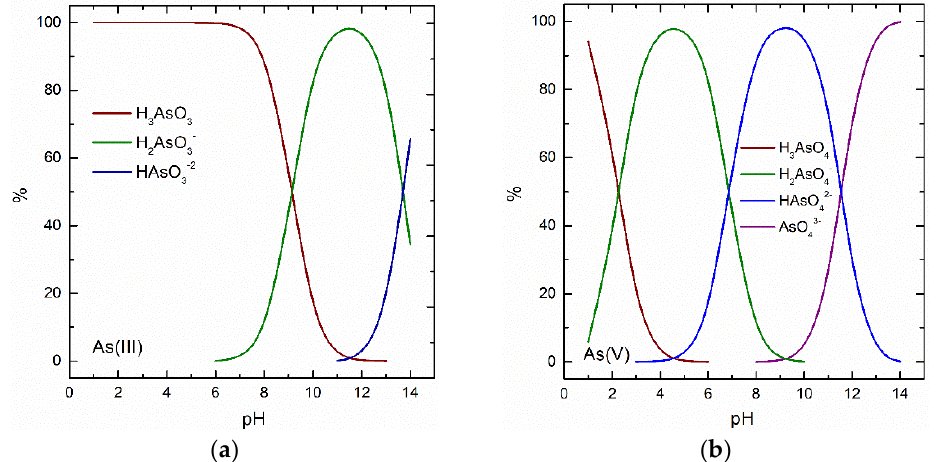
Figure 2. Speciation diagrams of ( a ) As(III) and ( b ) As(V) at ppb concentration level in natural-like water (water composition according to National Sanitation Foundation protocols), by applying MINTEQ 3 software [206].